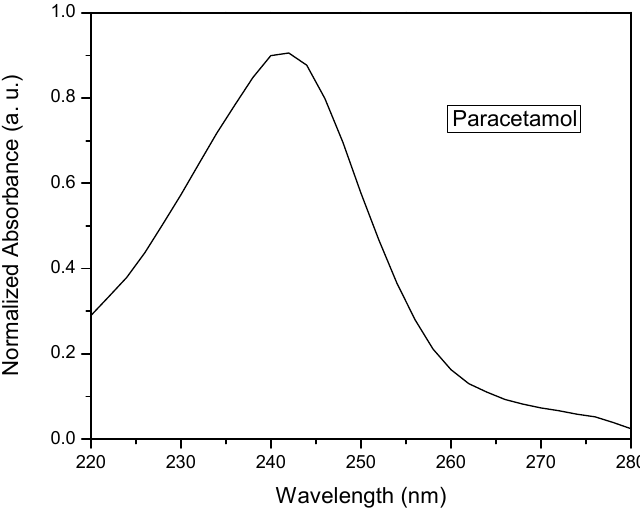
Figure 2. UV-vis absorption spectrum of normalized paracetamol.